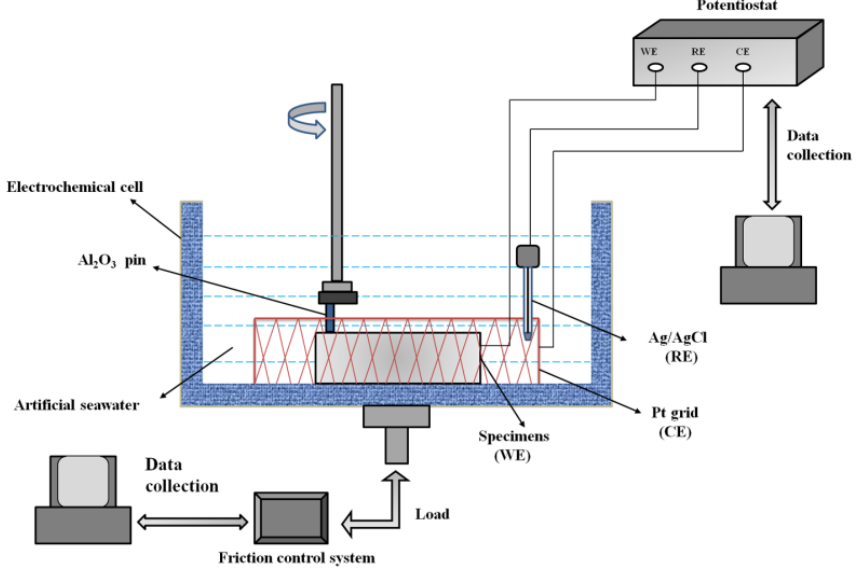
Fig. 1 Schematic of the tribocorrosion tester.